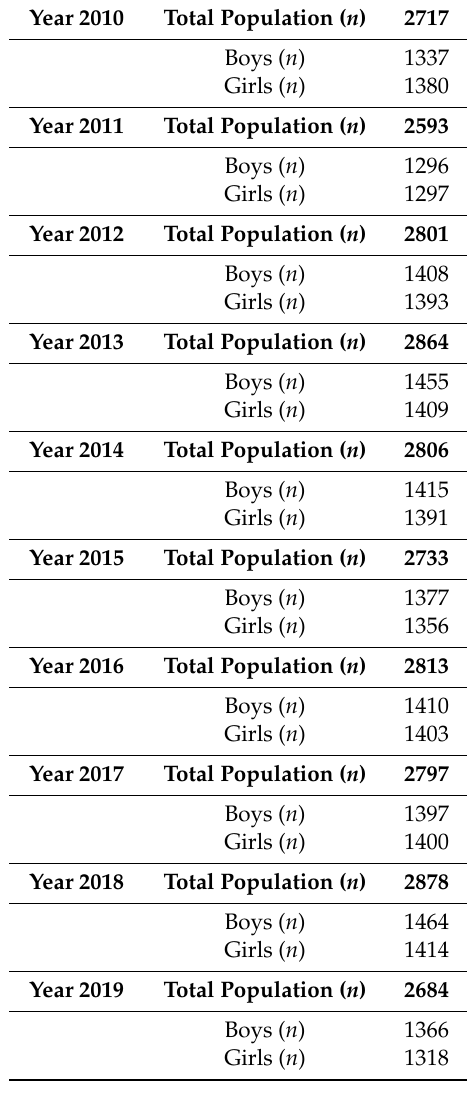
Table 1. Study population distribution from 2010 to